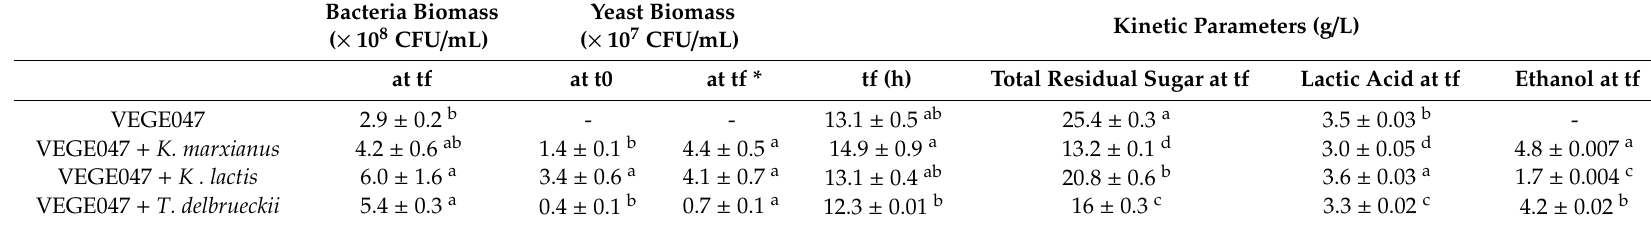
Table 1. Fermentation characteristics of the di ff erent